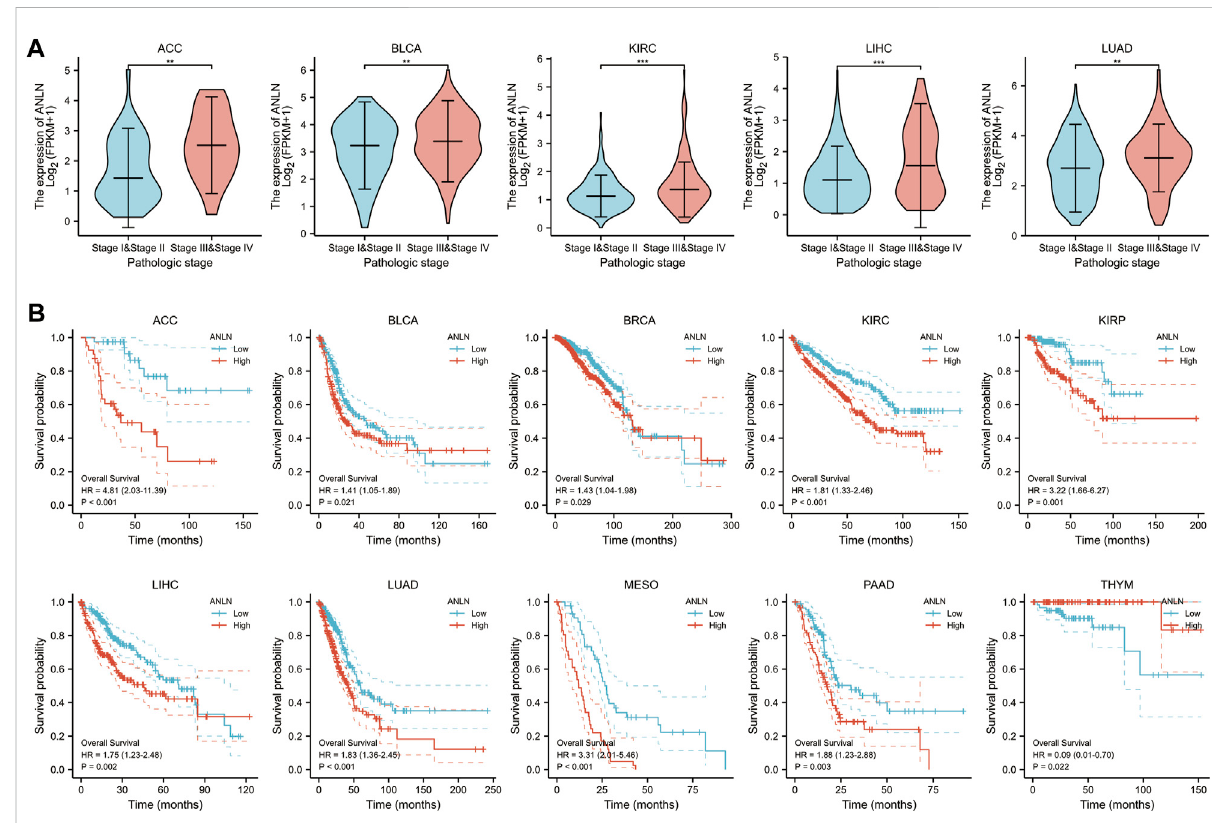
FIGURE 4 Correlation of ANLN expression with pathological stage and prognosis of tumors. (A) Correlation of ANLN expression with pathological stages of ACC, BLCA, KIRC, LIHC, and LUAD; (B) Correlation of ANLN expression with a prognosis of patients with ACC, BLCA, BRCA, KIRC, KIRP, LIHC, LUAD, MESO, PAAD, and THYM. * p < 0.05, ** p < 0.01, and *** p <